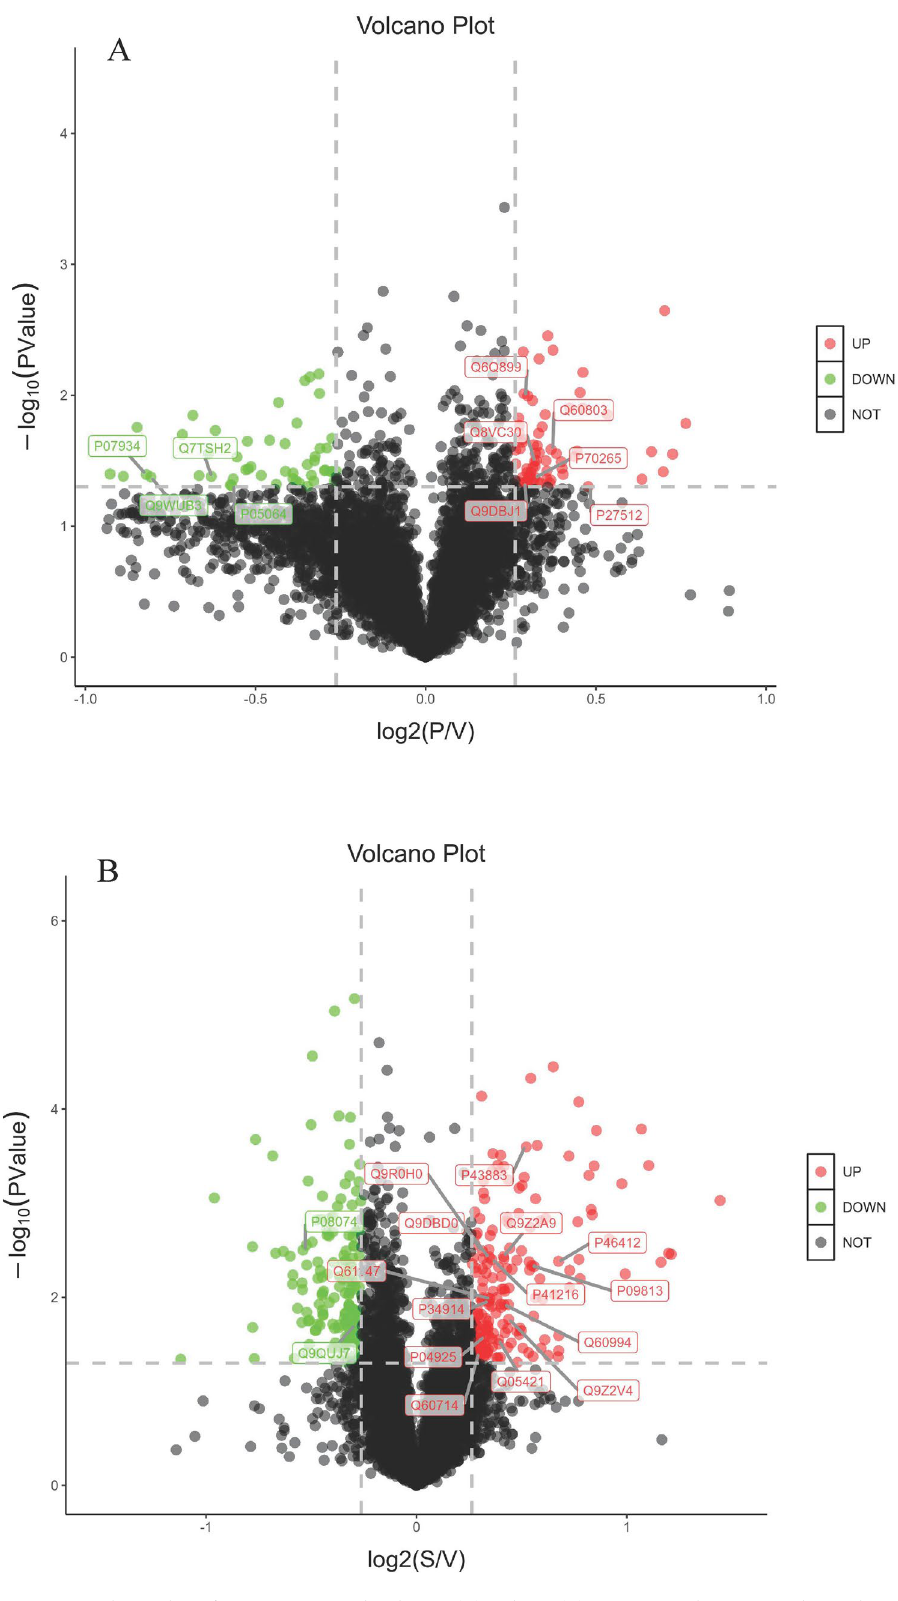
Figure 2. Volcano plots of proteomics treated with PZH ( A ) and sora ( B ) versus control group. In volcano plots, red and green spots represent differentially expression proteins (fold change > 1.2, p value < 0.05), and black spots represent the proteins changing insignificantly. The proteins of enriched KEGG pathways (fructose and mannose metabolism, glucagon signaling pathway and NF-kappa B signaling pathway in PZH vs. Control group, PPAR signaling pathway, arachidonic acid metabolism, and ferroptosis in Sora vs. Control group) were marked in the volcano maps, these proteins were selected to further PRM